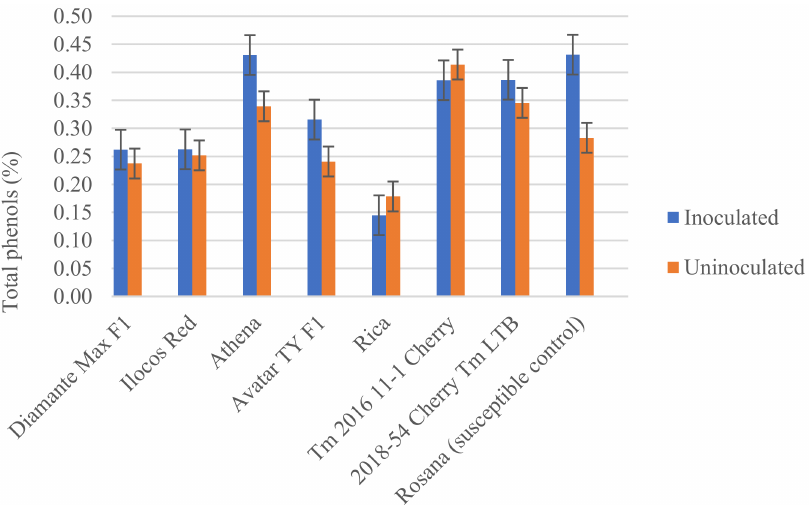
Figure 5. Average total phenols in gallic acid equivalents of extracts from different tomato varieties tested against Meloidogyne incognita. Error bars represent standard error of the mean.